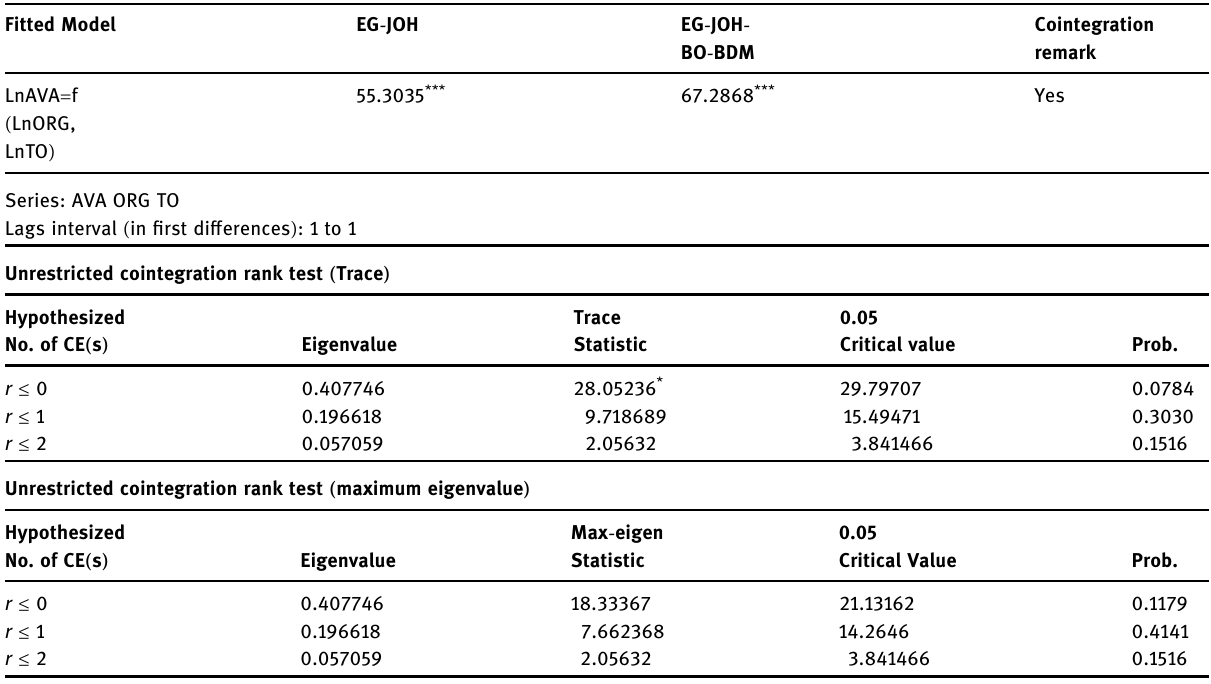
Table 5: Lag criteria